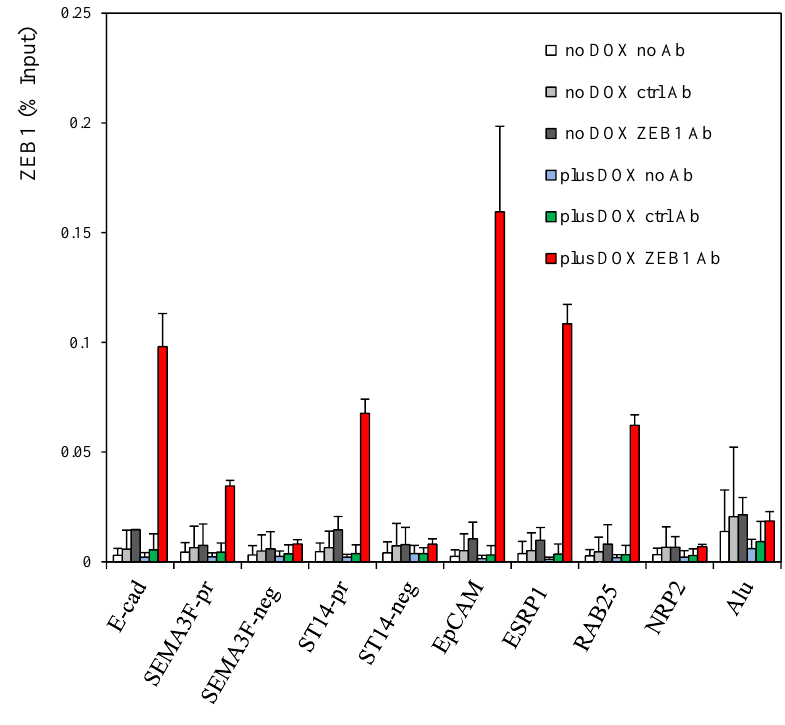
Figure 3. ZEB1 binds the targets genes. ChIP assays were performed with the rabbit anti-ZEB1 antibody on H358 FlipIn ZEB1 cells grown for 48 h in the absence or in the presence of DOX. As negative controls, ChIP assays were performed with IgG from a non-immunized rabbit and also in the absence of antibody. The previously described ZEB1 binding sites in the E-cadherin and SEMA3F promoters [9] were positive controls. Values are from three independent experiments with qPCR reaction in duplicate and are expressed as % of input. Bars,